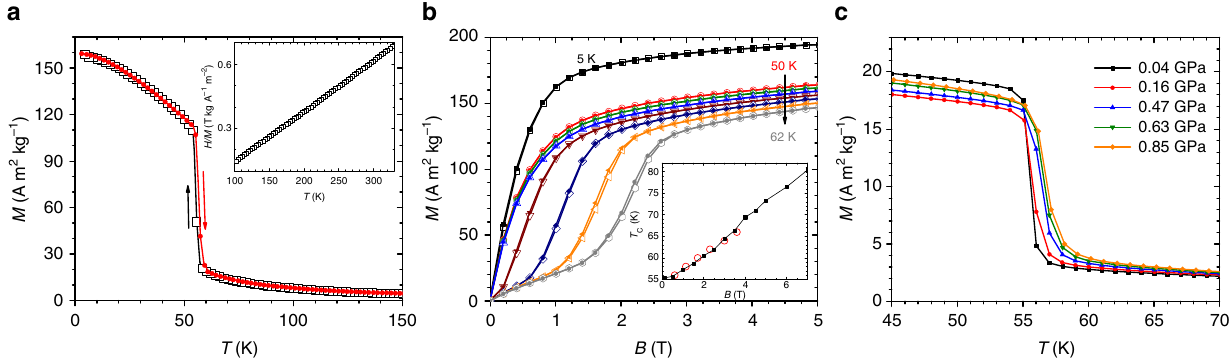
Fig. 2 Magnetic properties of Eu 2 In. a Magnetization ( M ) as a function of the temperature ( T ) measured upon cooling and heating in a magnetic fi eld ( B ) of 1 T. The inverse magnetic susceptibility in B = 0.1 T in the paramagnetic regime is displayed in the inset. b Isothermal magnetization data measured upon magnetization (open symbols) and demagnetization (closed symbols) for different temperatures: 5 K (squares), then from 50 to 62 K in 2 K increments. The inset displays evolution of the Curie temperature ( T C ) as a function of the magnetic fi eld derived from isothermal M ( B ) (circles) and iso fi eld M ( T ) measurements (squares, raw data not shown). c Temperature dependence of the magnetization measured at different applied pressures upon heating in B =